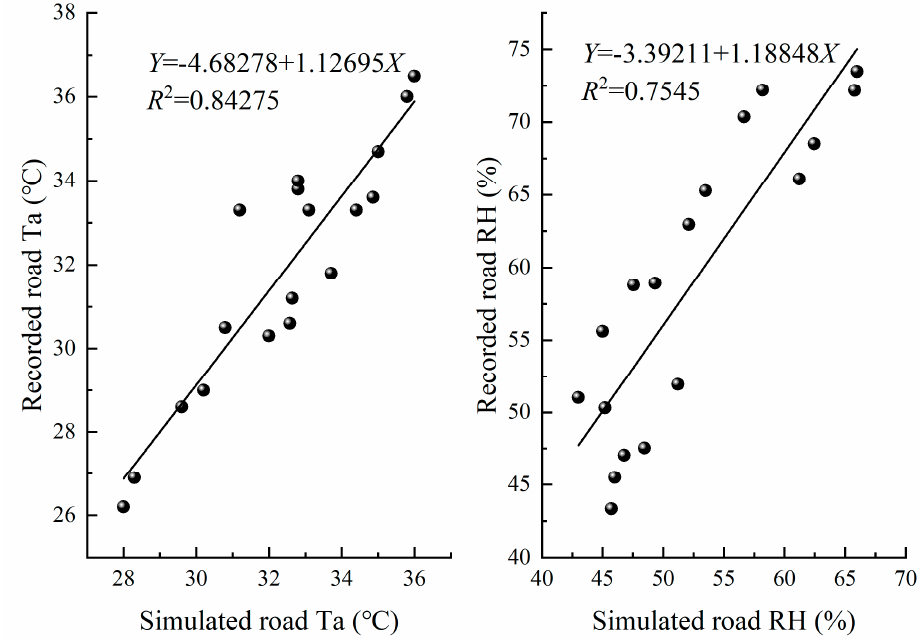
Figure 10. The correlation degree between simulated and measured data of road space.